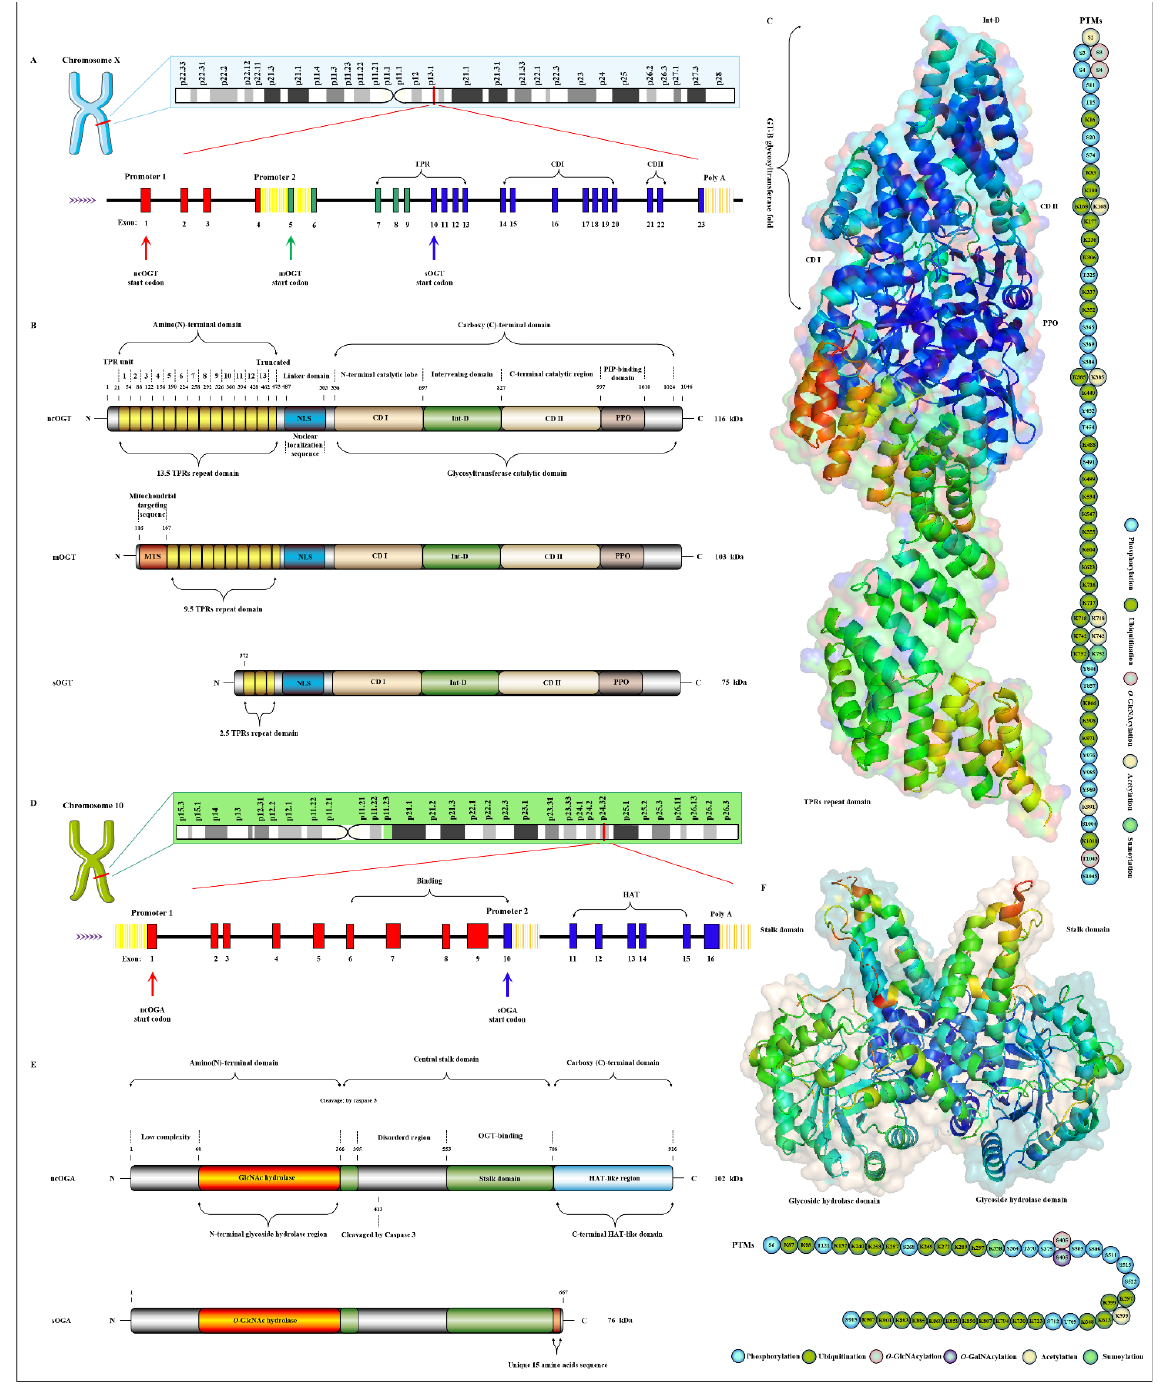
Figure 3. Genomic and proteomic structures of various subtypes of human OGT and OGA. ( A ) Human Ogt gene mapping and structure. ( B ) Primary protein structure of three subforms of human OGT. Subtype. ( C ) Advanced structures of human OGT in 3D and its PTMs. The advanced structure of OGA is displayed in cartoon and surface form with 5M7R in the protein data bank by PyMOL Molecular Graphics System, v2.5.2 (Schrödinger, LLC, New York, NY, USA). The various post-translational modification sites of OGT are present. These predicted modification sites are derived from the PhosphoSitePlus database (https://www.phosphosite.org, (accessed on 10 March 2022). ( D ) Human Oga gene mapping and structure. ( E ) Primary protein structure of three subforms of human OGA. Subtype. ( F ) Advanced structures of human OGA in 3D and its